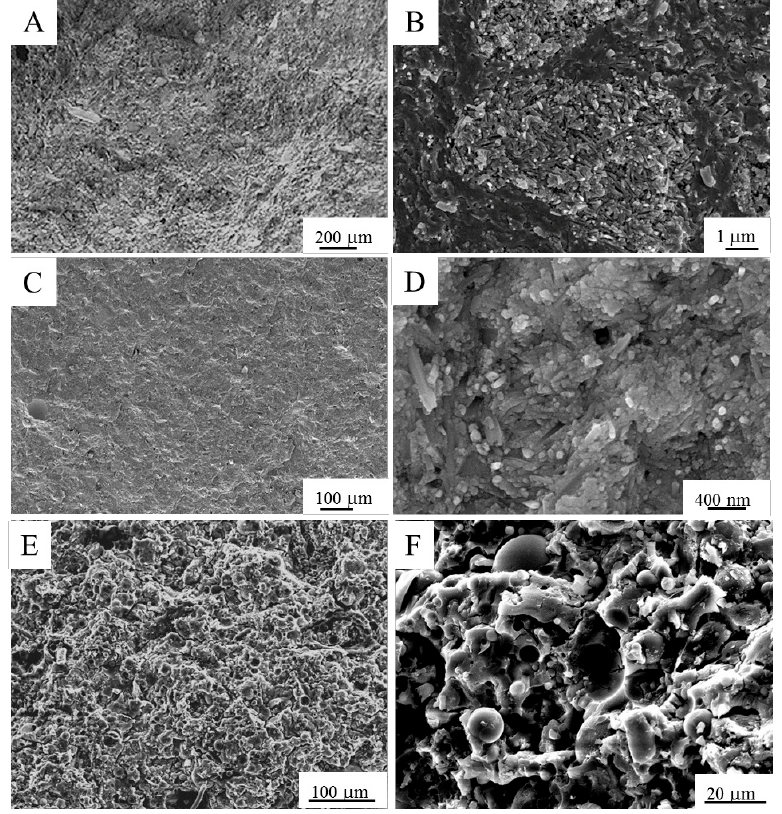
Figure 6. FESEM micrographs of the fracture surfaces of HL-S ( A , B ); HL-R ( C , D ) and FA-R ( E , F ).